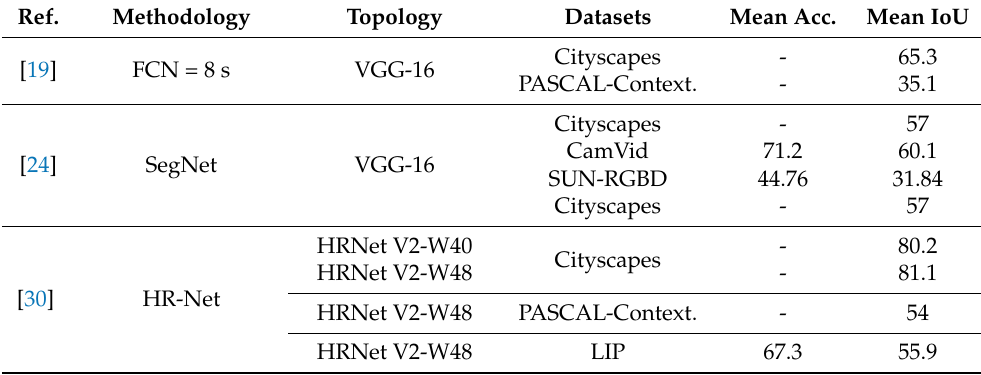
Table 1. Comparison of semantic segmentation neural networks for different databases. Ref.